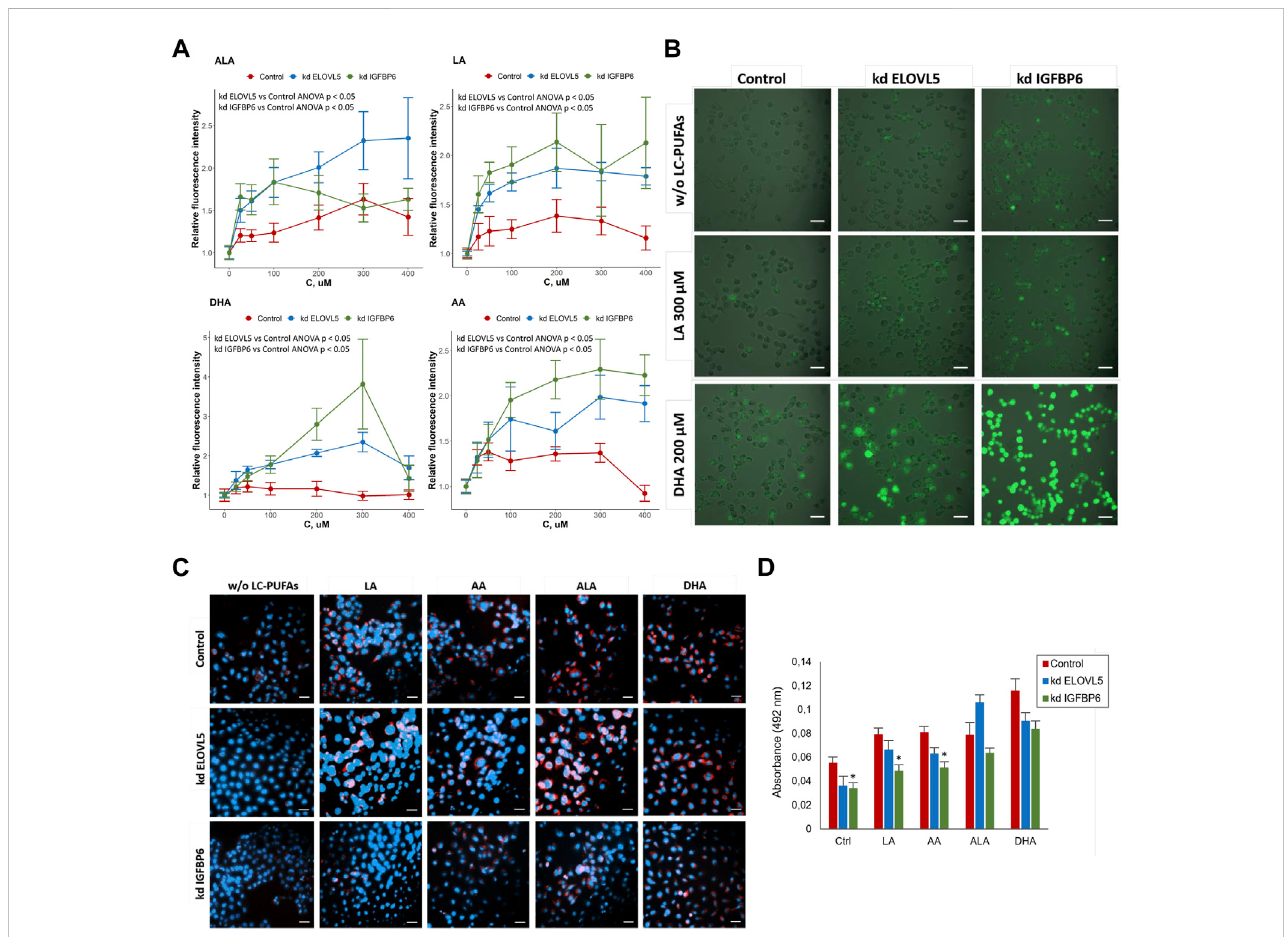
FIGURE 6 (A) Assessment of oxidative stress in MDA-MB-231 cells under the in fl uence of various LC-PUFA by detection of reactive oxygen species (ROS) with H2DCFDA. Error bars represent standard error of mean (SEM, n = 3). (B) Photo of MDA-MB -231 cells in the cell culture medium without external LC-PUFAs andwithadditionof300 μ MLAor200 μ MDHA(stainingwithH2DCFDA).Scalebarsindicate50 μ m. (C) LipiddropletsstaininginMDA-MB-231cellsincontrol medium and in the medium containing 50 μ M of LA, AA, ALA and DHA. Scale bars indicate 50 μ m. Nuclei (blue) were stained with 4 ′ ,6-diamidino-2- phenylindole(DAPI), lipid droplets (red) werestained with OilRed O. (D) Quanti fi cation of lipid droplets inMDA-MB-231 cells after treatment with various LC- PUFAs. The diagram represents absorbance of extracted Oil Red O. Error bars represent standard error of mean (SEM, n =